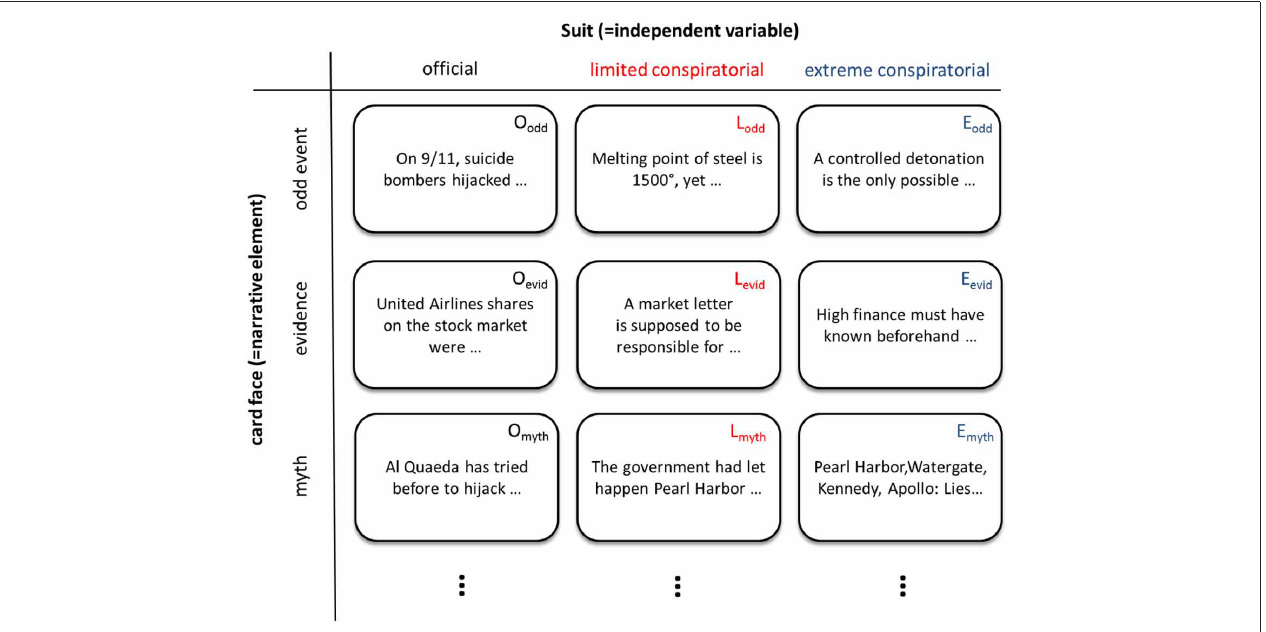
FIGURE 1 | Overview of the narrative construction